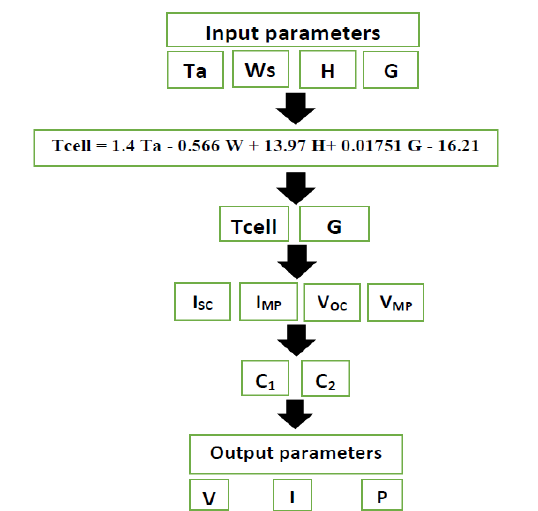
Fig. 3. Flow chart of mathematical model for PV solar